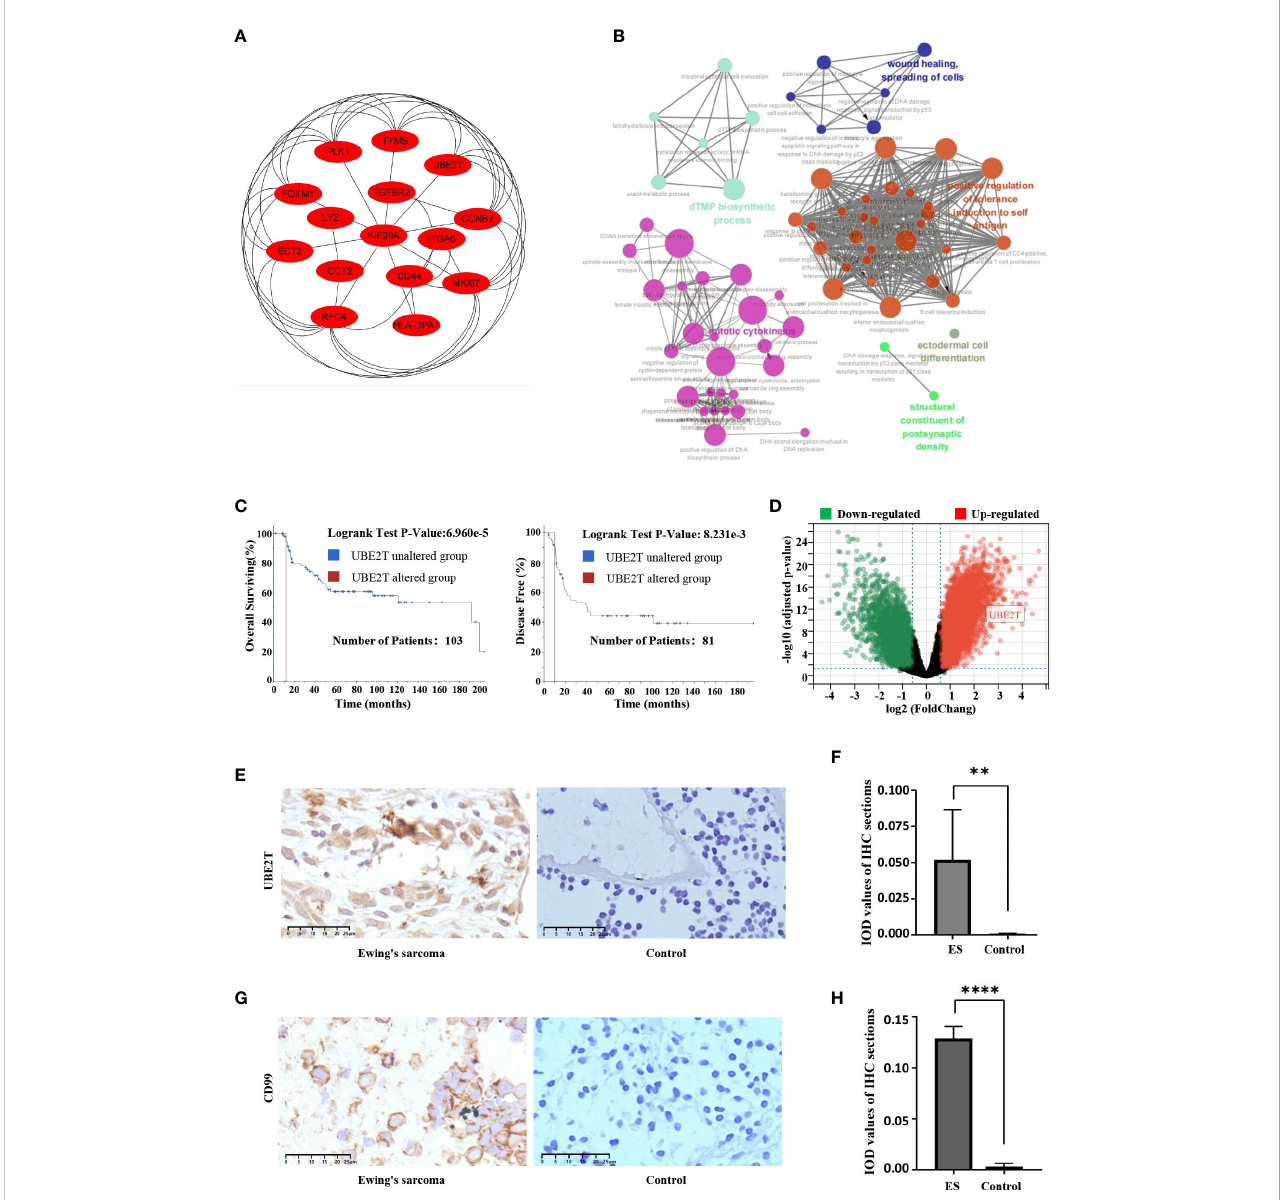
FIGURE 4 The hub genes ’ connection network and biological process research; Core-DEG obtained by the cBioPortal web and veri fi ed by the GSE68776 and IHC. (A) The hub genes were obtained by CytoHubba with 15 nodes and 43 edges. (B) ClueGO was utilized to examine the biological processes of hub genes. The node ’ s dark hue represents the recti fi ed P value of ontologies. The quantity of genes participating in ontologies is represented by node ’ s size. P < 0.01 was judged statistically meaningful. (C) The cBioPortal of fi cial website was employed to complete overall surviving and illness-free surviving studies of core-DEG, P < 0.05. (D) The volcanic plot showed expression of UBE2T in validation set GSE68776, with |log2FC| ≥ 1.5, adjusted P <0.05. (E – H) The IHC fi ndings revealed that the UBE2T protein (E, F) and CD99 (G, H) were overexpressed in ES but not in normal tissues, and the Student ’ s t test